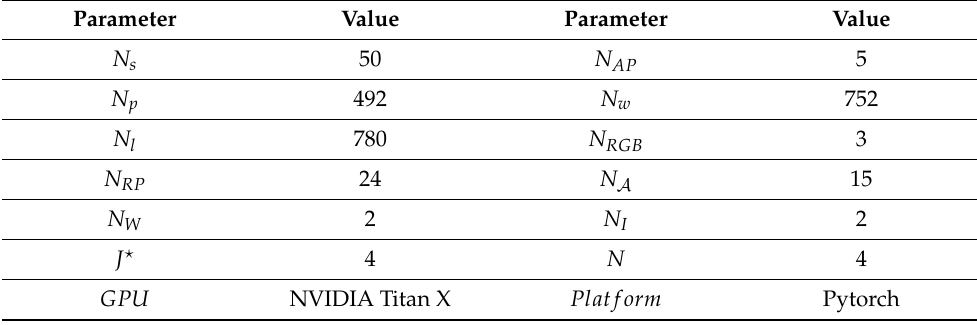
Table 2. The detailed parameter values of the